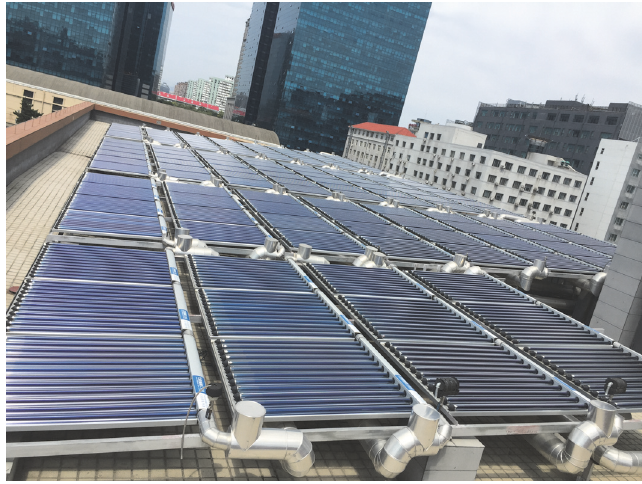
Figure 2: Photograph of evacuated tube solar collector with CPC re fl